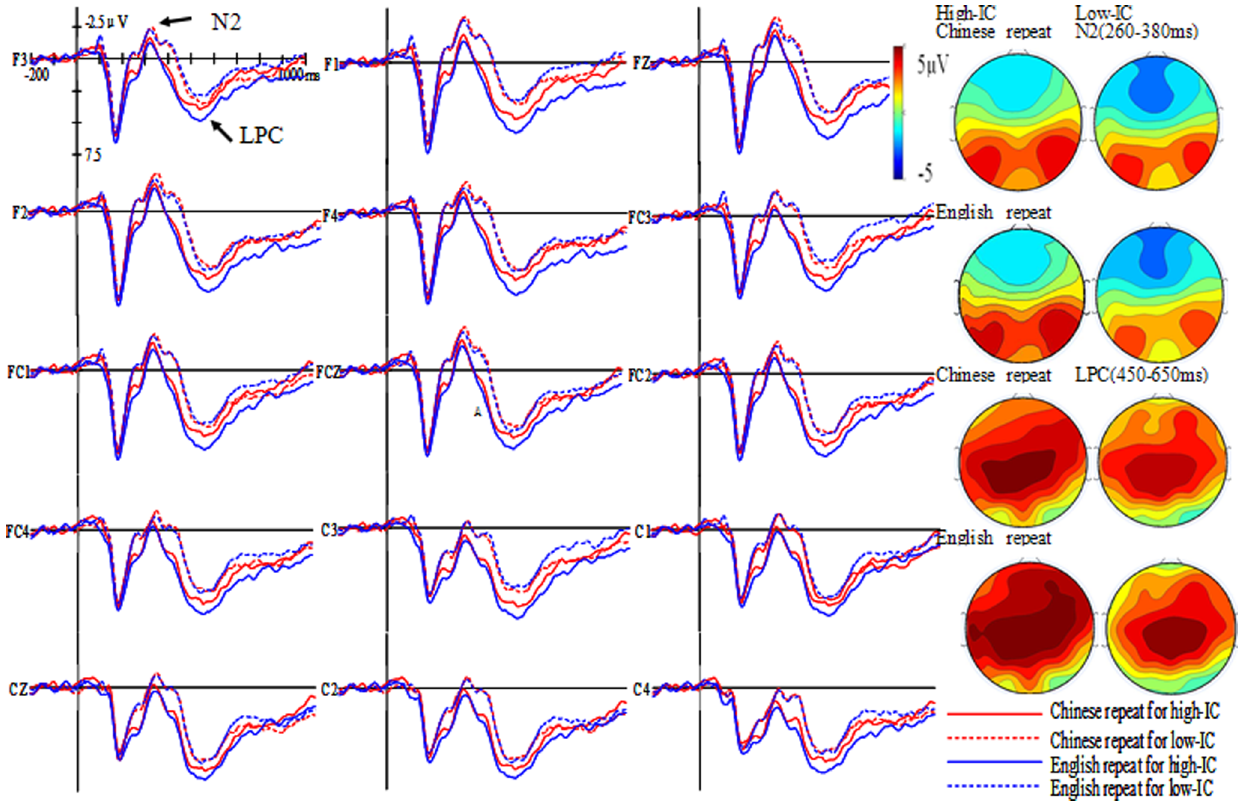
Figure 2. Grand average waveforms and topographic maps for L1 and L2 repeat trials for the high and low inhibitory control (IC)